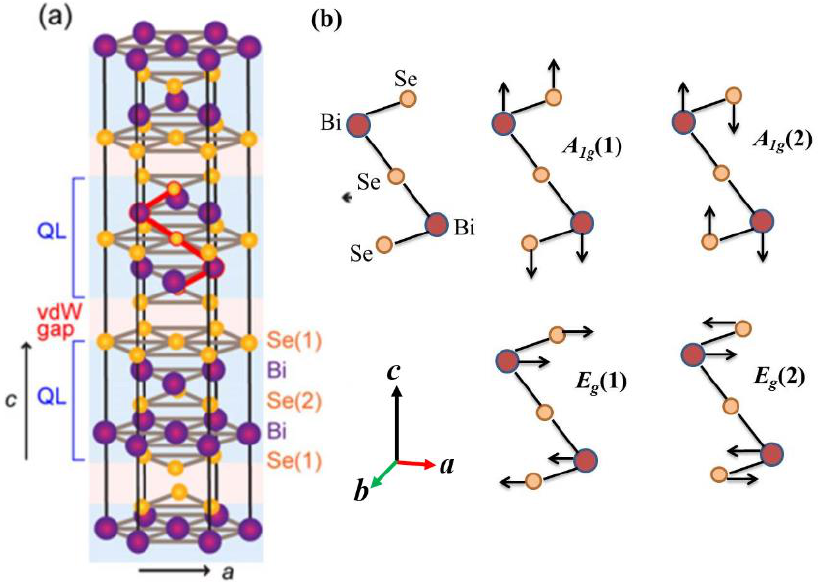
Figure 1. ( a ) Schematic of the Bi 2 Se 3 crystal structure showing the quintuple layer and the location of the van der Waals gaps. ( b ) Atomic displacements of the four Raman-active modes.